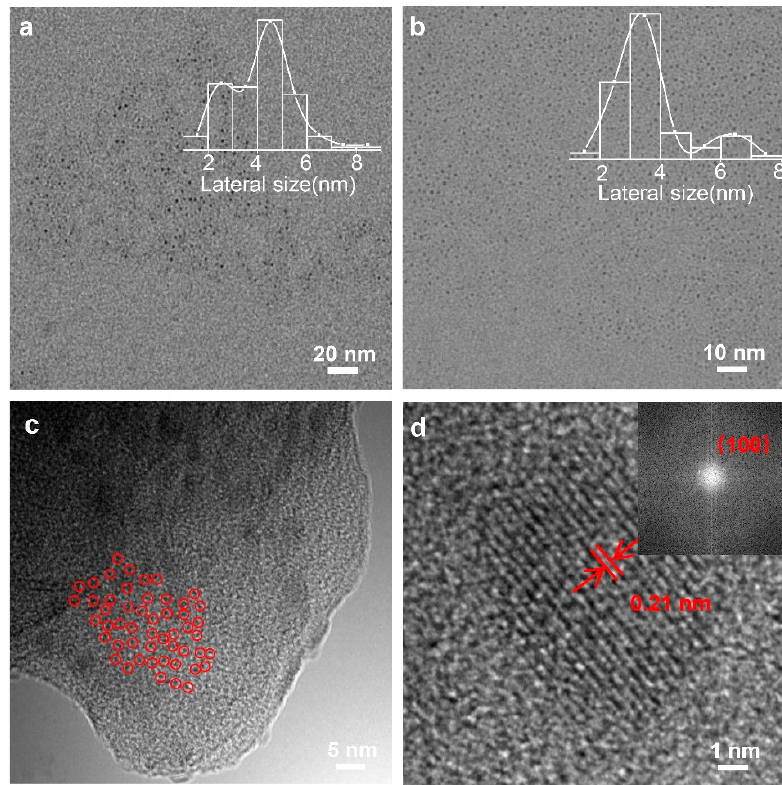
Figure 1. ( a , b ) TEM images (insets: lateral size distributions) of CDs and Co-CDs in teh x50.0 K version. ( c ) TEM image of Co-CDs@CB, and the red circles represent the loaded Co-CDs. ( d ) High-resolution TEM image of Co-CDs@CB and the corresponding FFT pattern.